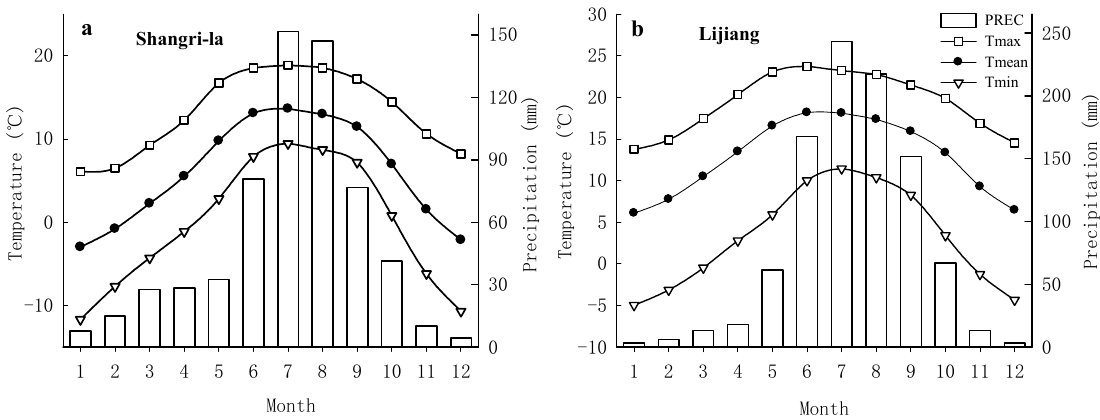
Figure 2. Climate diagrams for ( a ) Shangri-La (1960–2011) and ( b ) Lijiang (1951–2010) meteorological stations. PREC: monthly total precipitation; Tmin: monthly mean minimum temperature; Tmean: monthly mean temperature; Tmax: monthly mean maximum temperature.